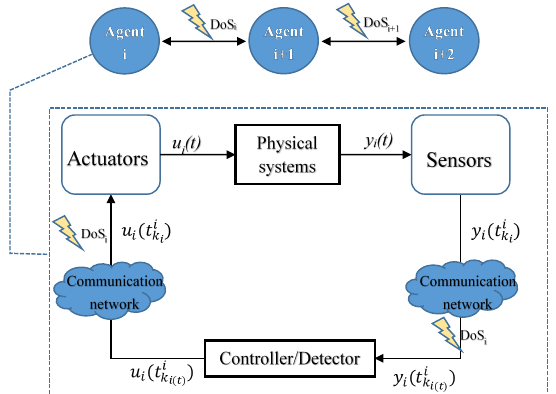
Figure 1. Multi-agent systems under DoS attack. DoS attacks may occur on the sensor–controller channel or the controller–actuator channel, affecting the transmission of system output signals and control signals, respectively. Hacker can also launch DoS attacks that can be independent of each other on different